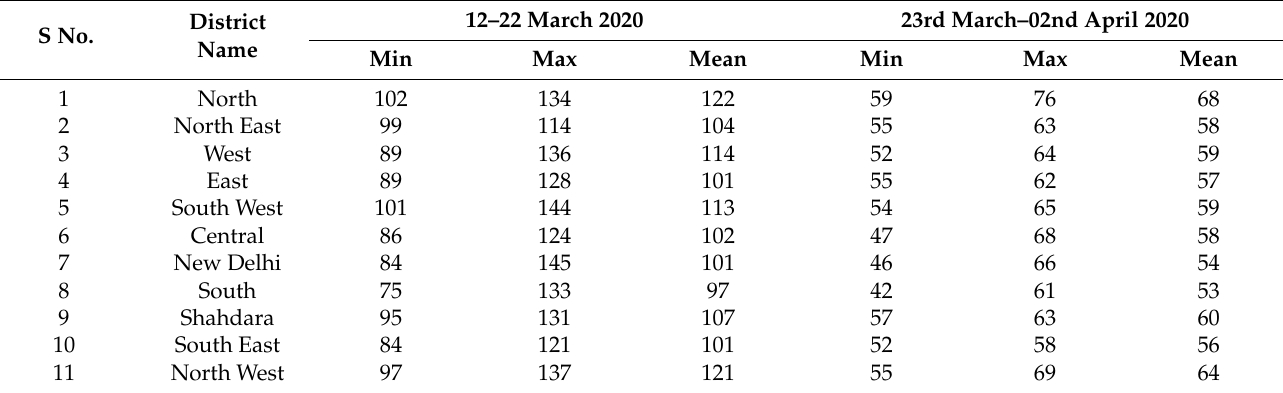
worst by COVID-1 9′ s restrictions, which have led to the global shutdown of all commer-